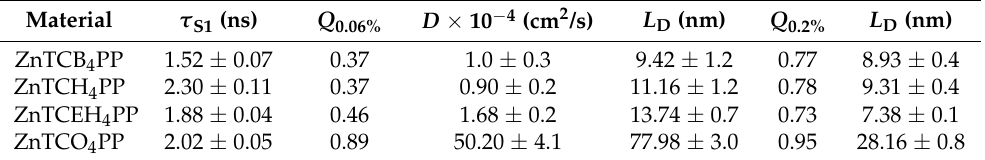
Table 1. Alkylated ZnTCA 4 PP summary of average singlet lifetime decays ( τ S1 ), relative steady state quenching efficiency ( Q ) for dopant volume fractions 0.06% and 0.2%, exciton diffusion coefficient ( D ) and diffusion length ( L D